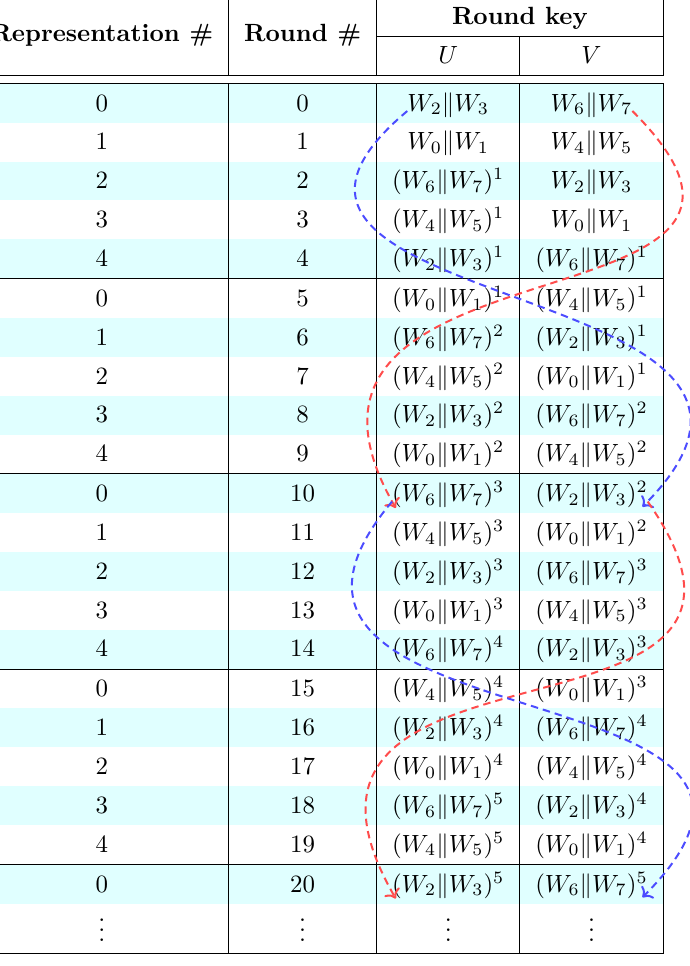
Table 8: Round keys’ representations depending on the round number. Exponents refer to the number of times the key words have been updated. Blue and red arrows refer to double and triple key updates,